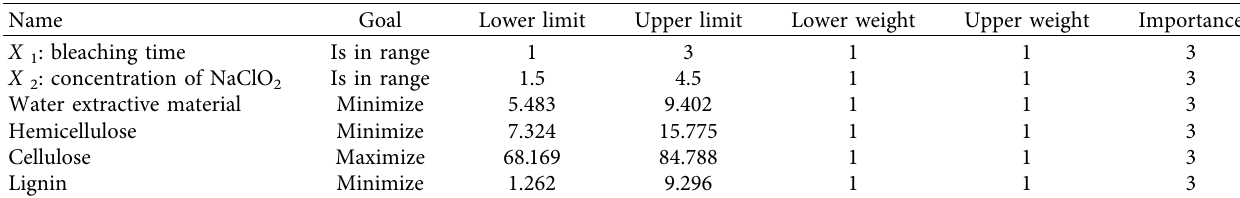
Figure 2: Contour and response surface model of (a) water-extractive materials, (b) hemicellulose, (c) cellulose, and (d) lignin. Table 6: Constraint data of